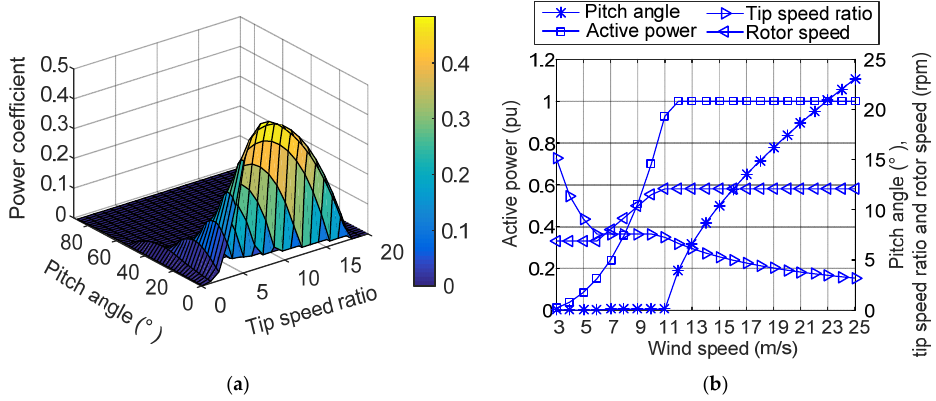
Figure 2. NREL DFIG 5 MW wind turbine with: ( a ) power coefficient in respect to pitch angle and tip speed ratio; ( b ) active power, pitch angel, tip speed ratio, and rotor speed in respect to the wind speed with Maximum Power Point Tracking (MPPT) control. Table 1. Parameters of NREL 5 MW wind turbine [28].